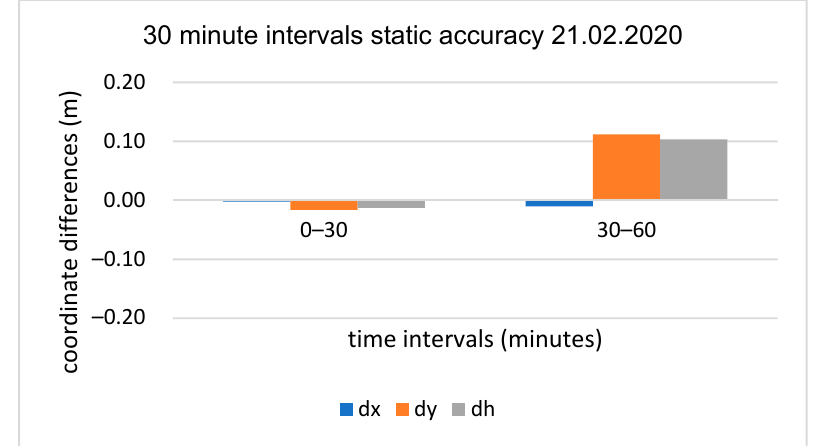
Figure 13. 20 min sub-session positioning results for the second test, baseline OPNT–P30Pro (4 km).